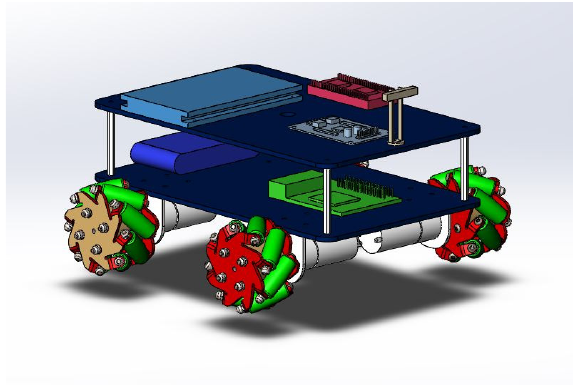
Figure 10. Low-cost design scheme of